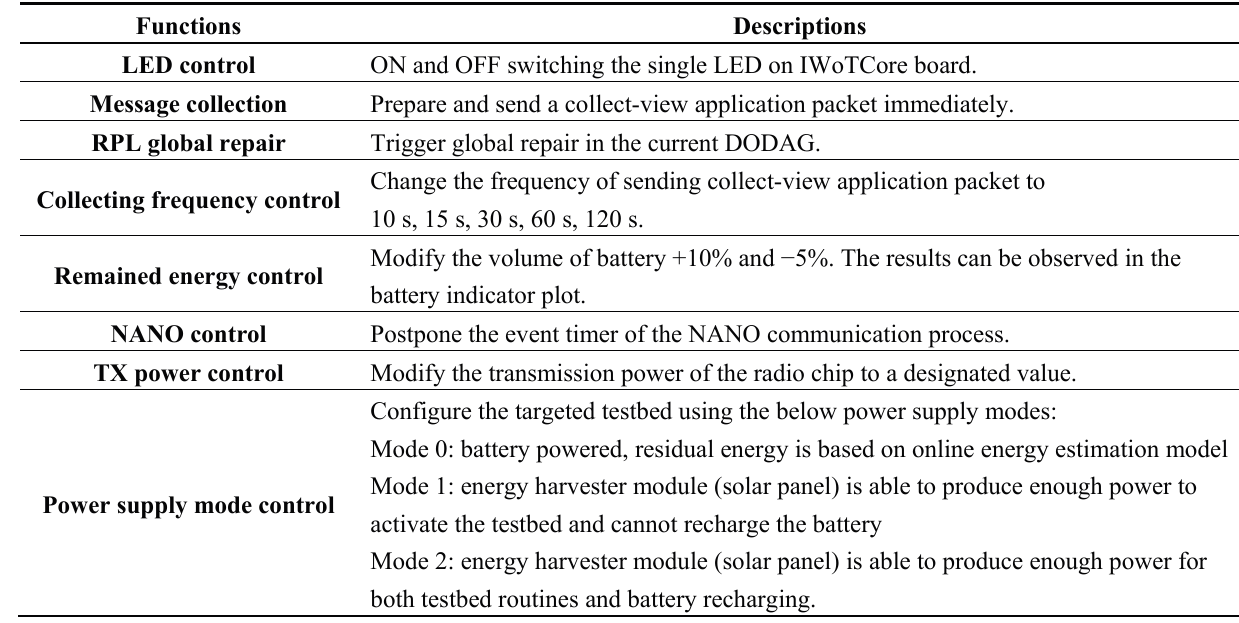
Table 13. Remote control and fault injection